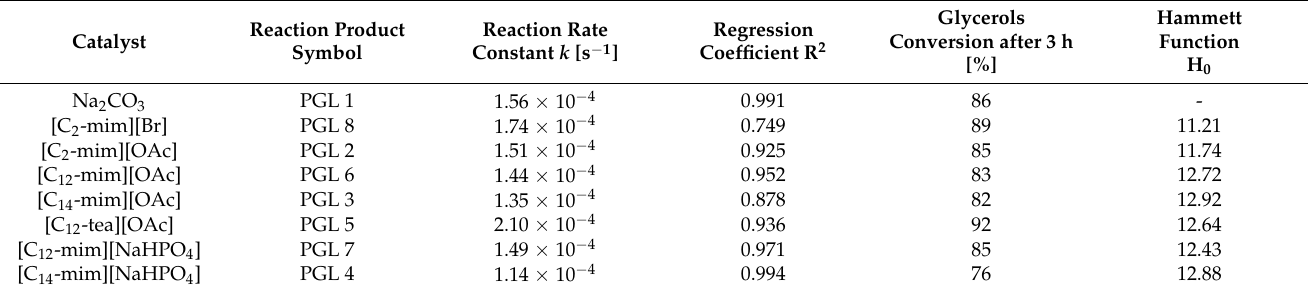
Table 2. The influence of the catalyst on the efficiency of glycerin oligomerization reaction (180 ◦ C, 400 mbar, 3